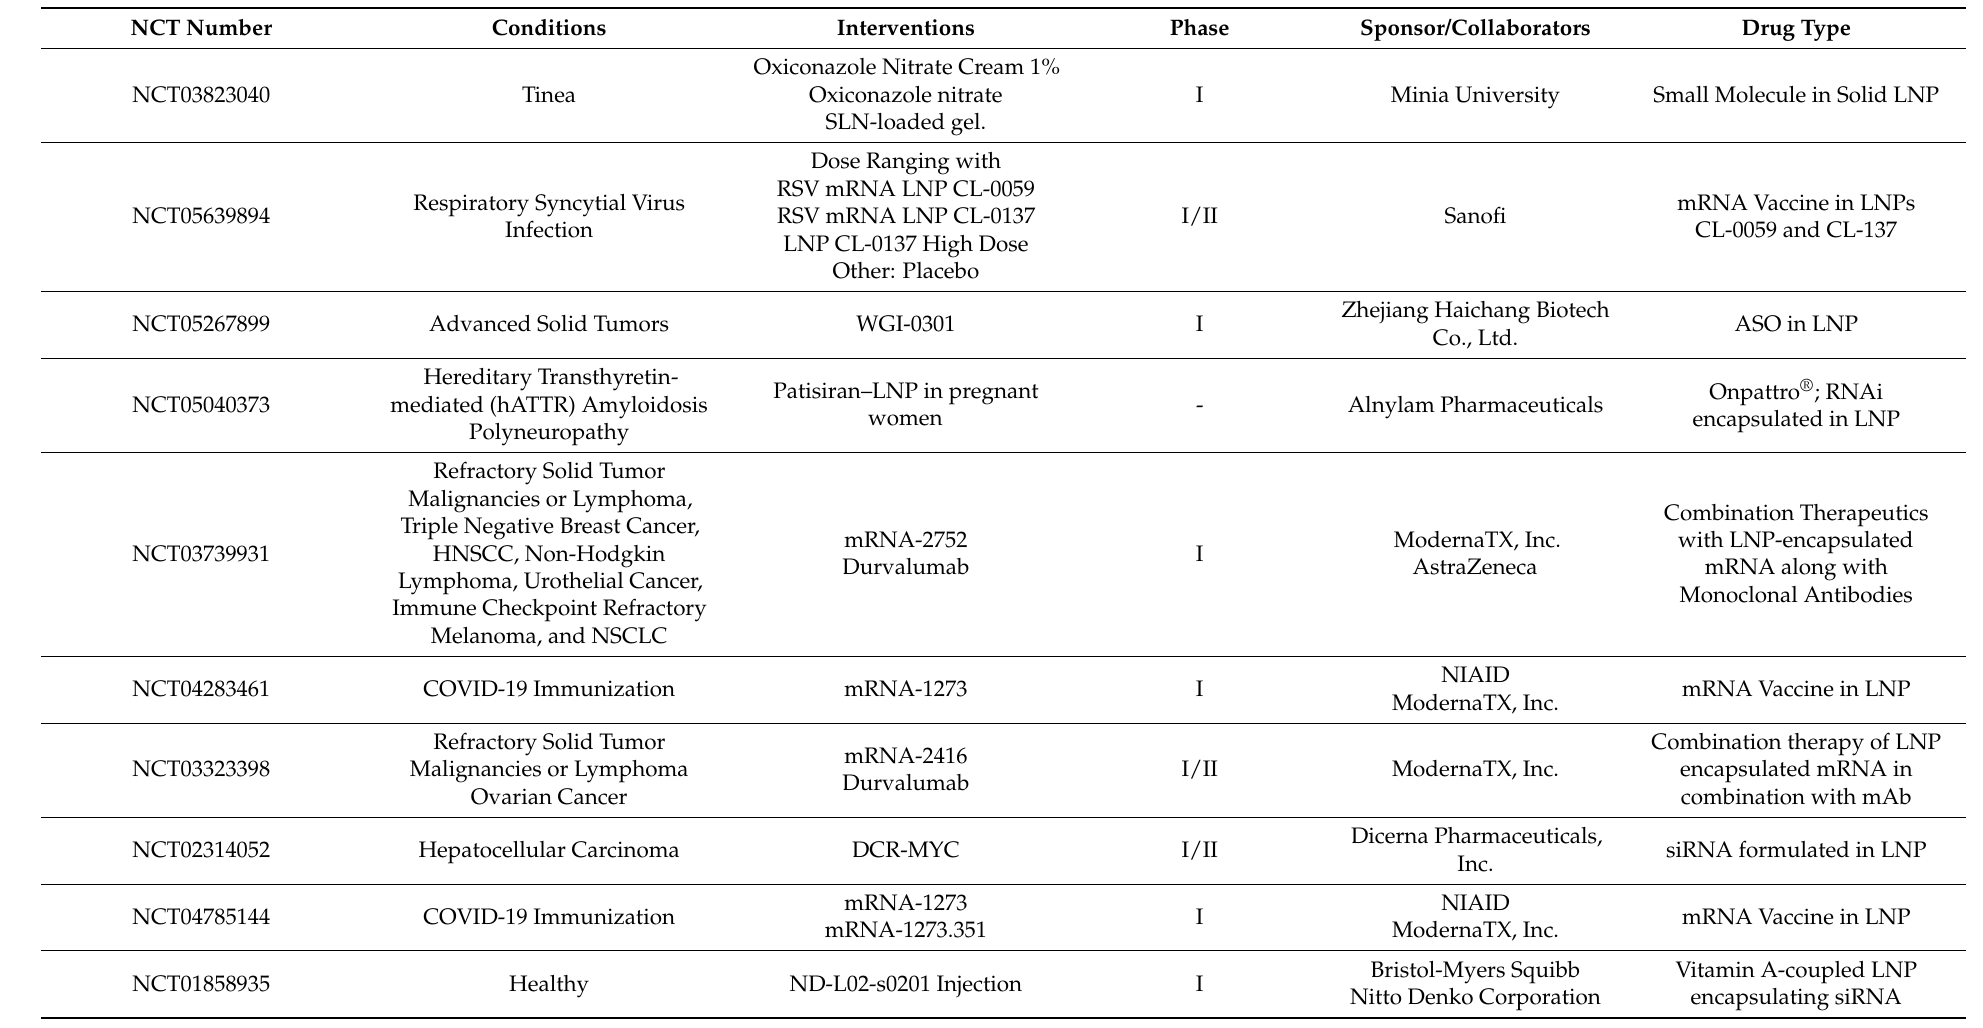
Table 1. Currently ongoing clinical trials with LNP systems as per